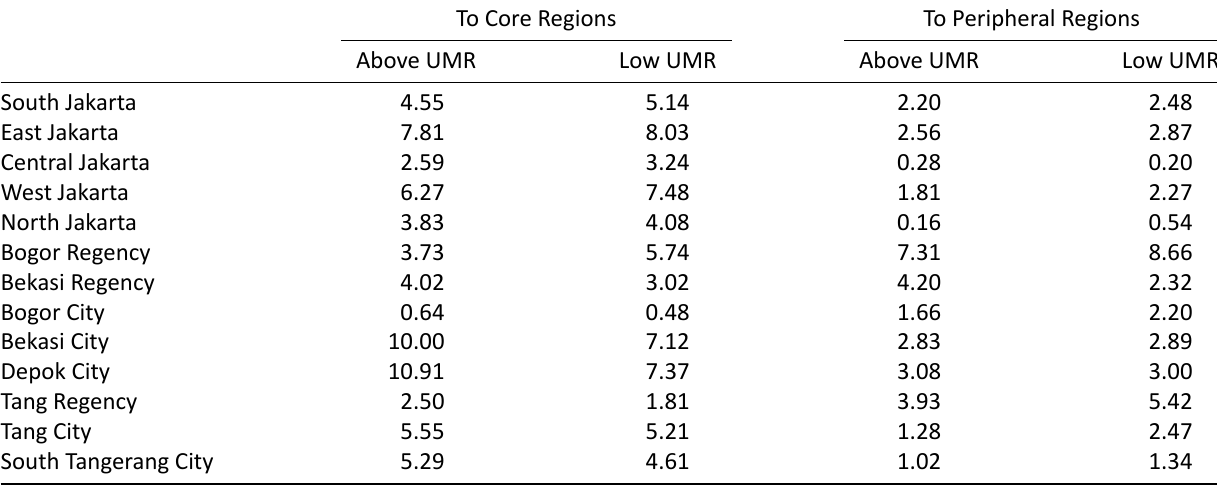
Table 4. Salary range proportion (%), by commuting destination. To Core Regions To Peripheral Regions Above UMR Above